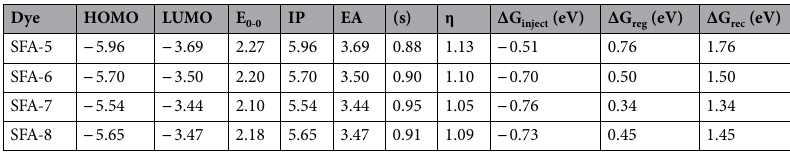
Table 3. Quantum chemical parameters of the SFA-5–8 synthesized